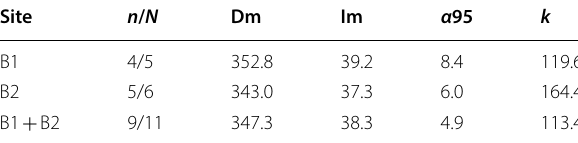
Table 1 Mean ChRM directions for